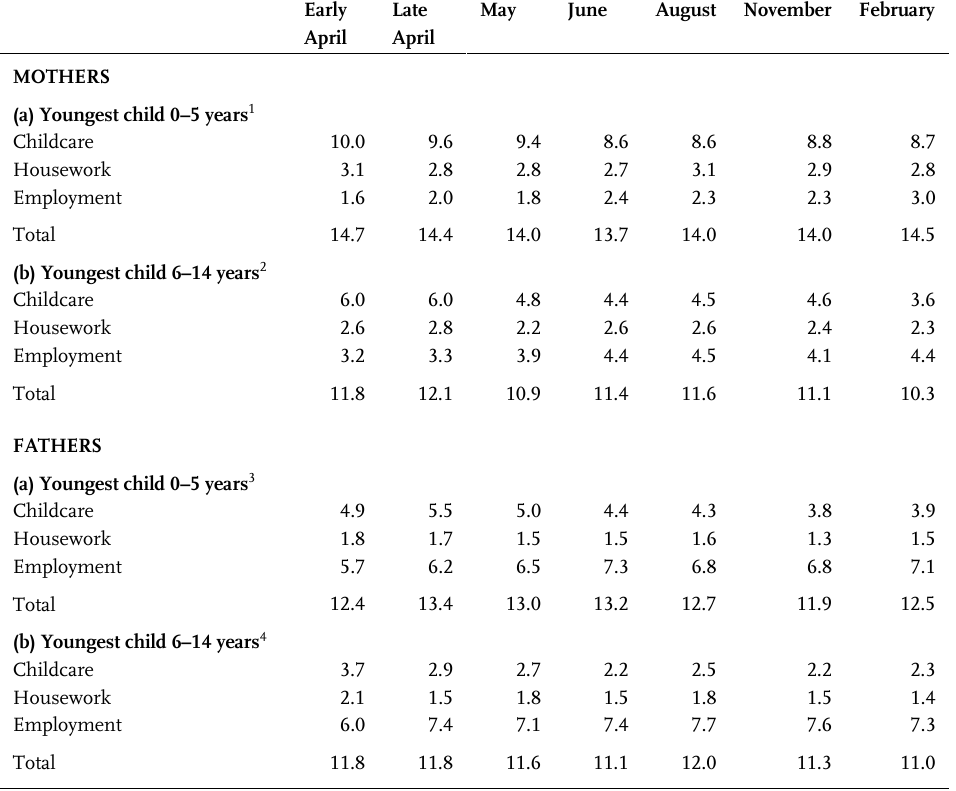
Table A3: Mean hours per weekday with childcare, housework, and employment by age of the youngest child